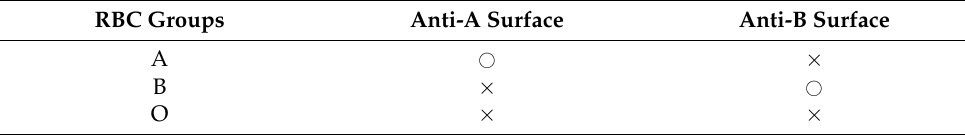
Table 1. Qualitative test of the standard specific antibody-antigen interaction using cell-tearing assay *. RBC Groups Anti-A Surface